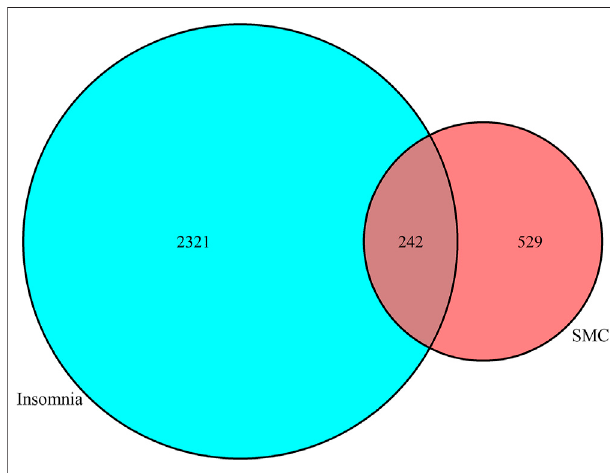
FIGURE 1 | Venn diagram revealing 242 common potential therapeutic targets between SMC and